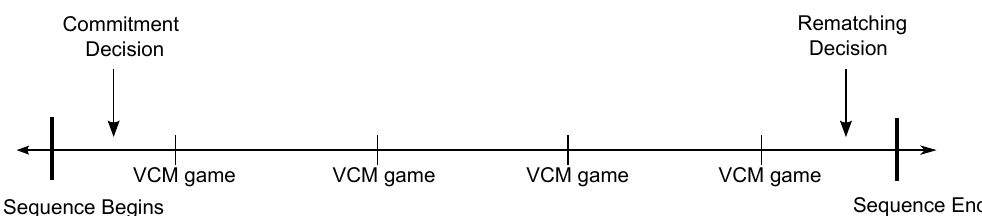
Figure 1. Timeline of a typical sequence in the